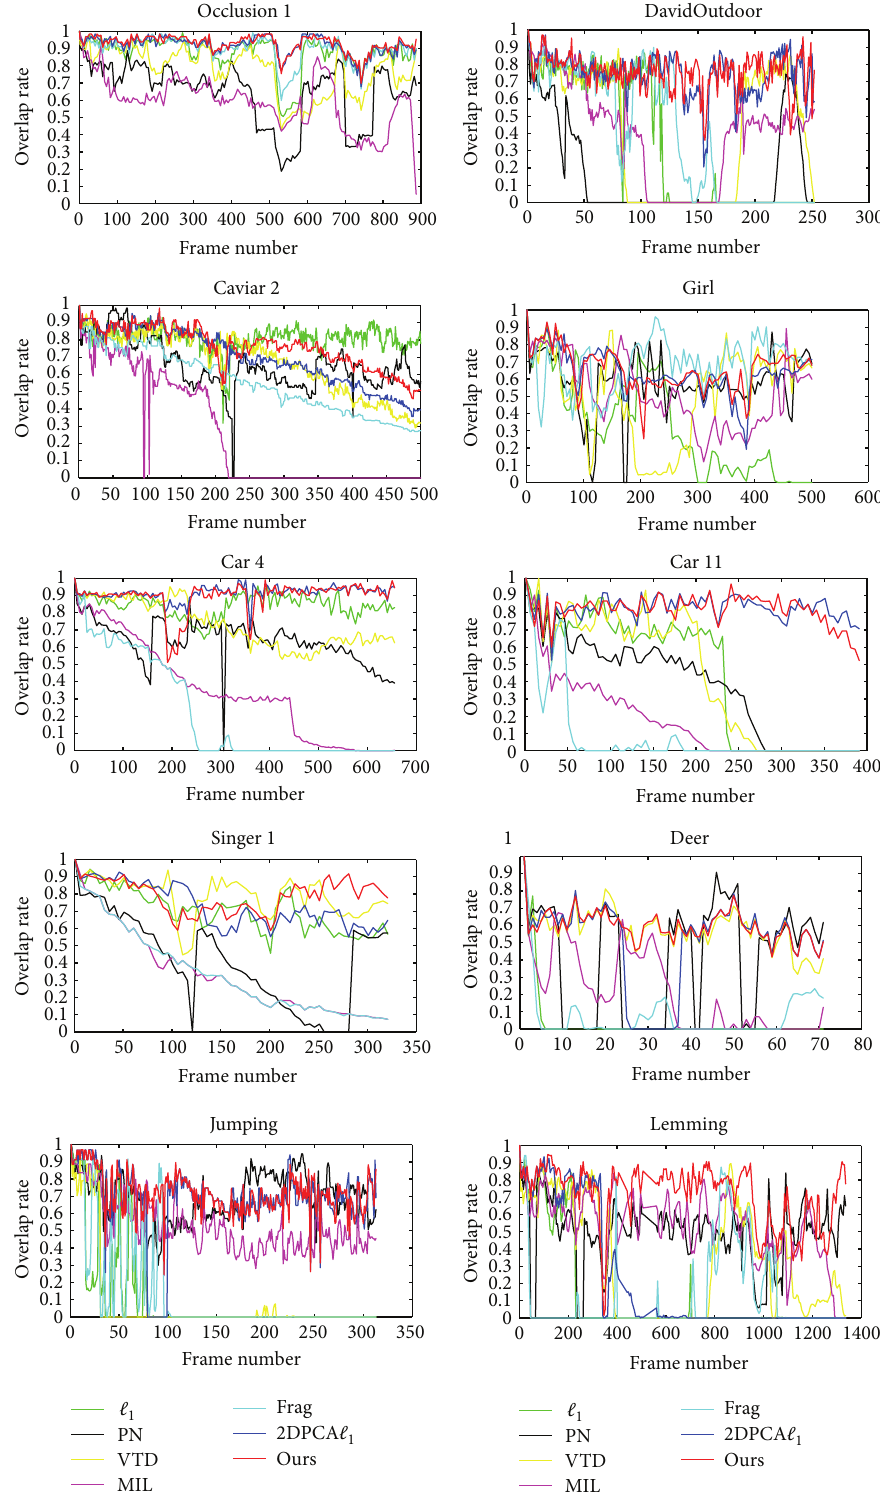
Figure 3: Overlap rate